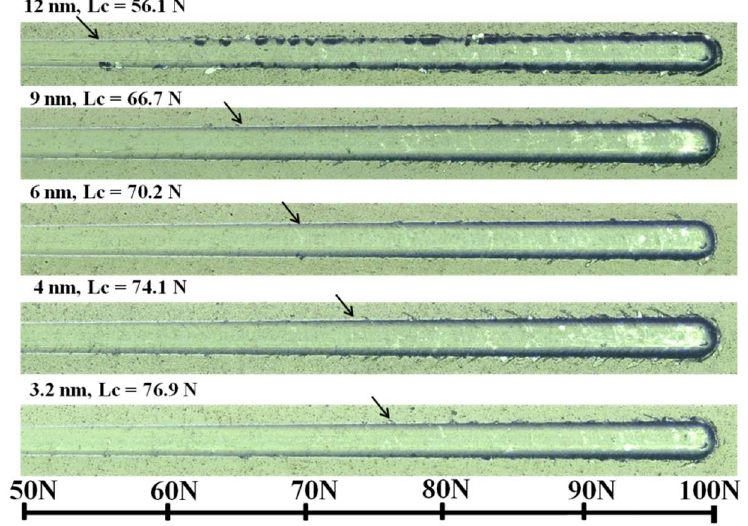
Figure 7. Scratch tracks of CrN/CrAlSiN multilayer coatings with bi-layers of various thicknesses.